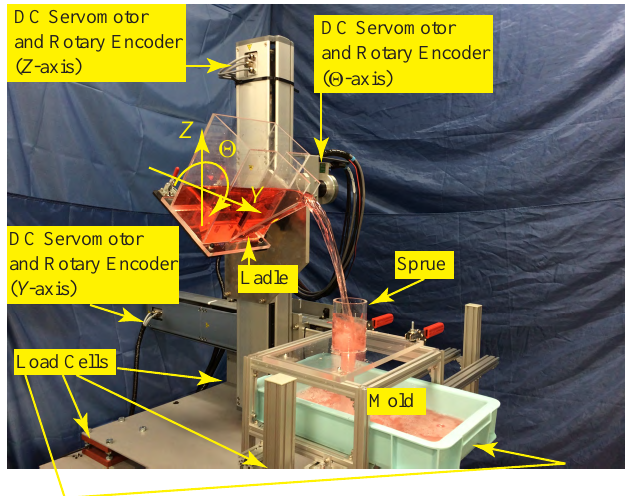
Figure 16. Laboratory-type automatic pouring